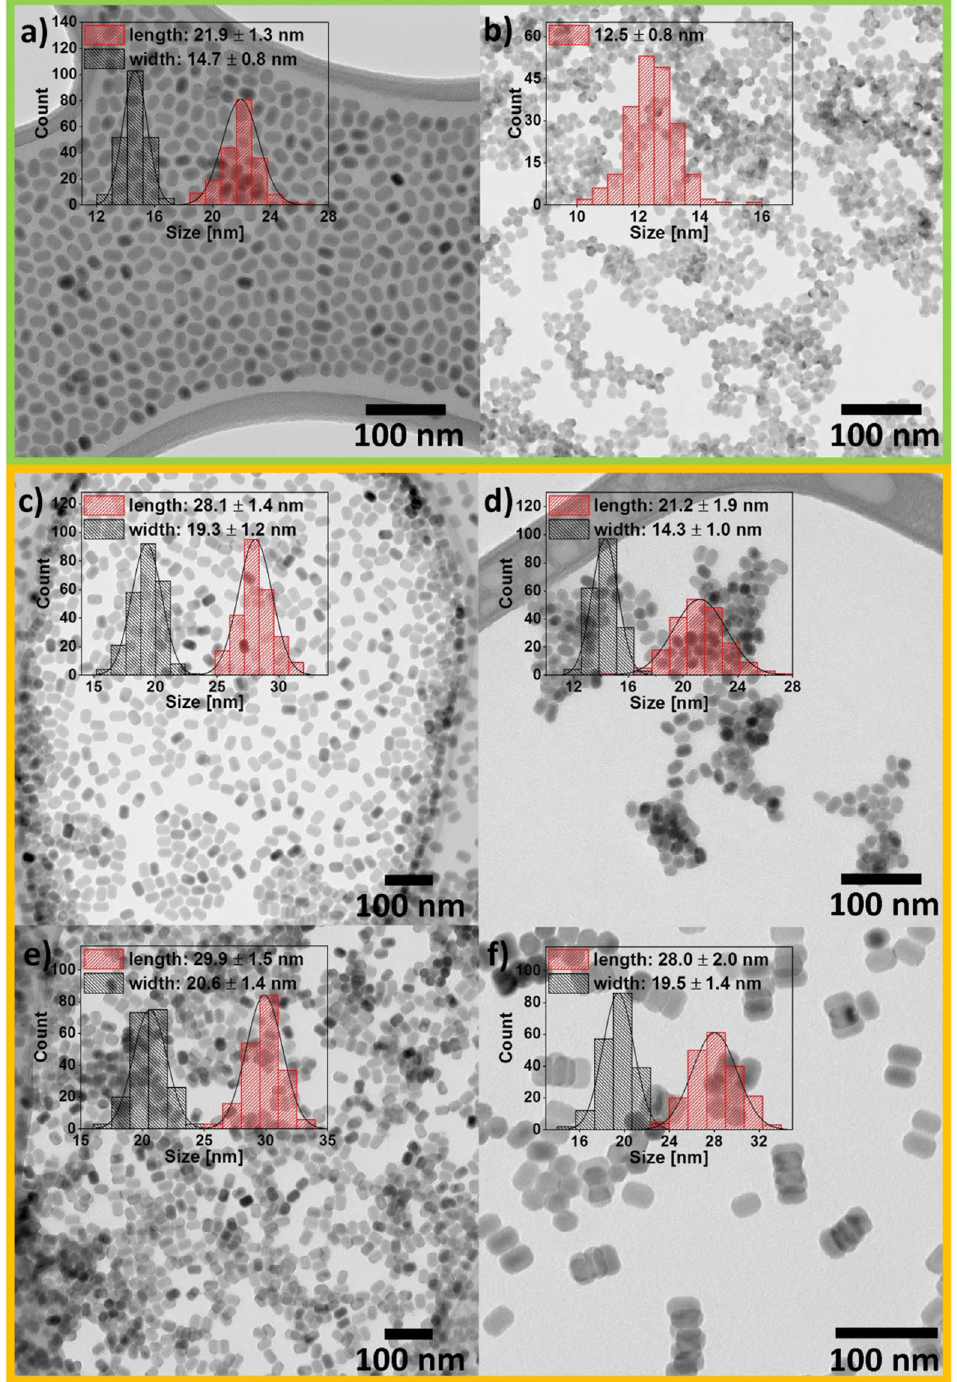
Figure 3. TEM images and particle size distribution of ( a , c ) OA-capped and ( b , d , e , f ) ligand-free NaYF 4 :Yb 3+ ,Er 3+ /NaYF 4 UCNPs. Different modification conditions were used ( b , d ) 2 M/2 h, ( e ) 0.1 M/2 h, and ( f ) 2 M/15 min, which denote the HCl molarity and the time of mixing, respectively. Color coding is used to indicate the UCNPs obtained from the RE acetates (green) and the RE chlorides